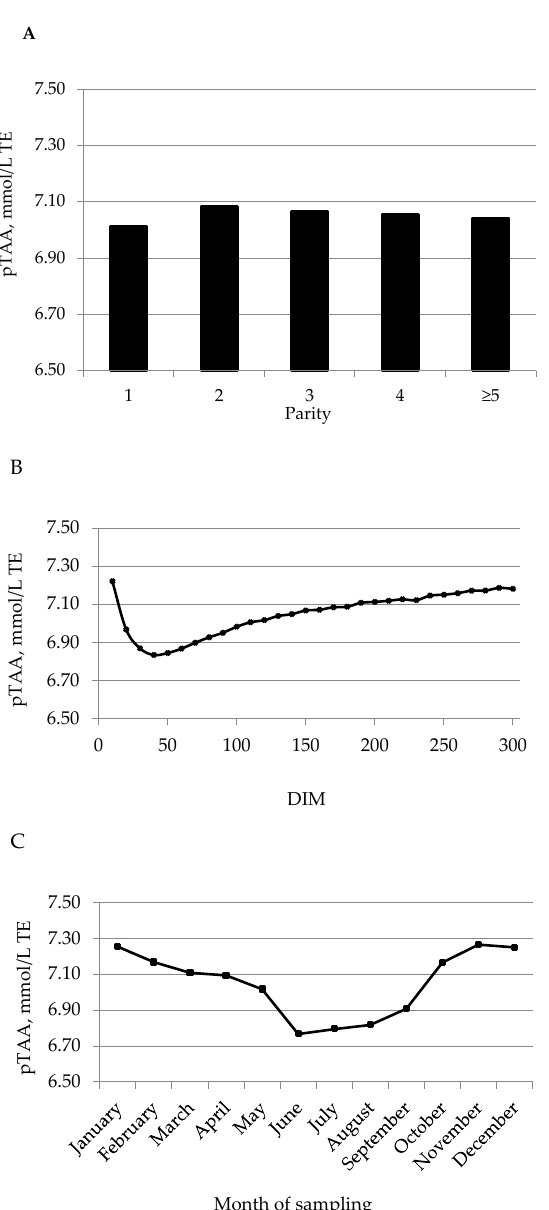
Figure 1. Least squares means of bovine milk predicted total antioxidant activity (pTAA) expressed as mmol/L of Trolox equivalents (TEs) for the fixed effects of (A) parity (SE < 0.008), (B) days in milk (DIM; SE < 0.009), and (C) month of sampling (SE < 0.015).